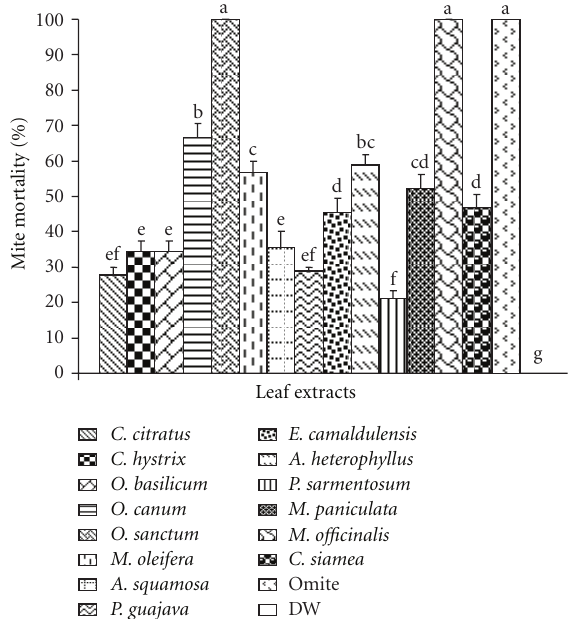
Figure 2: The mortality rates of adult female Luciaphorus sp. after being treated with 5% leaf extracts at 3 days after application. Bars (mean ± SE) with same letter(s) are not significantly di ff erent as determined by LSD test at P < 0 .